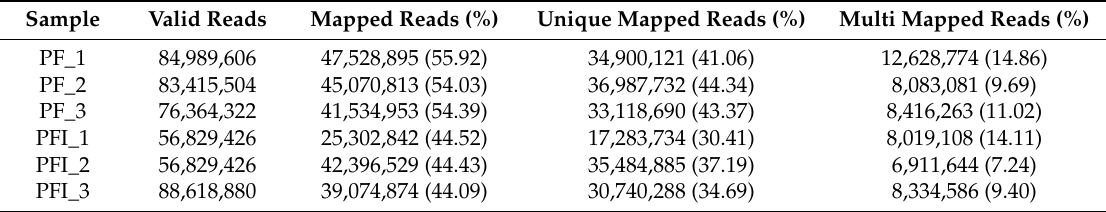
Table 3. Mapped to the